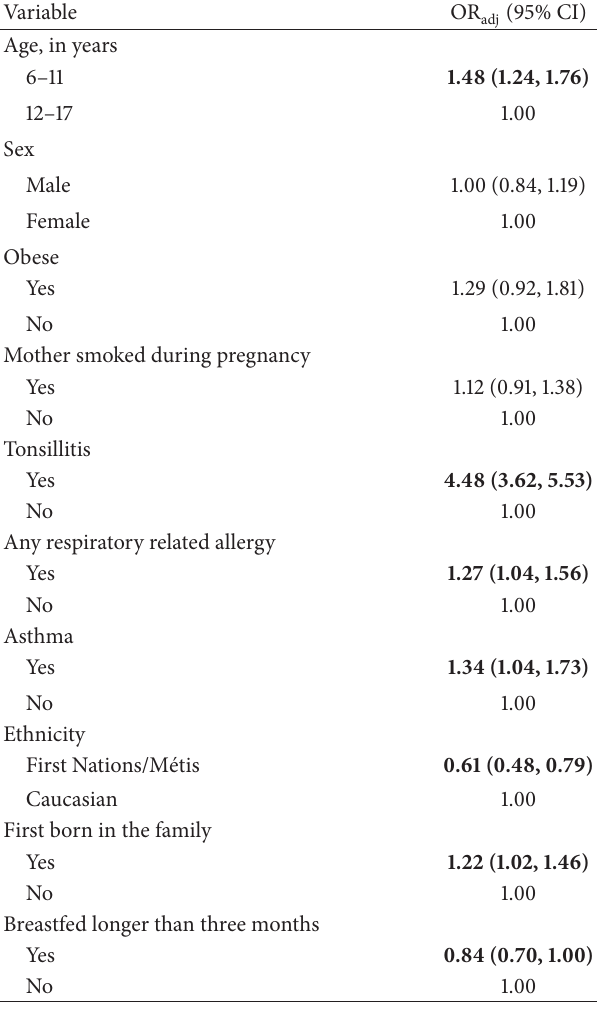
Table 3: Adjusted odds ratios (95% confidence intervals) based on multivariate logistic regression for associations with physician diagnosed ear